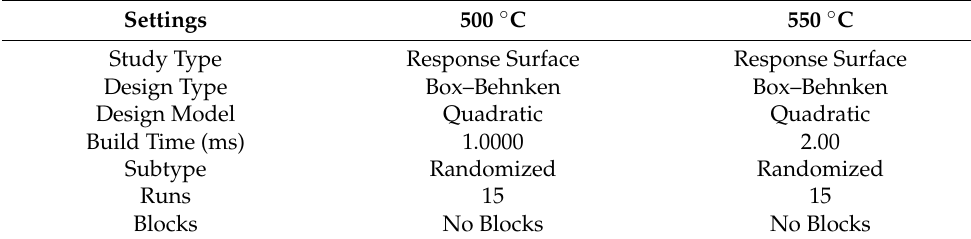
Table 1. The setting of RSM model for pyrolysis at 500 ◦ C and 550 ◦ C. Settings Study Type Response Surface